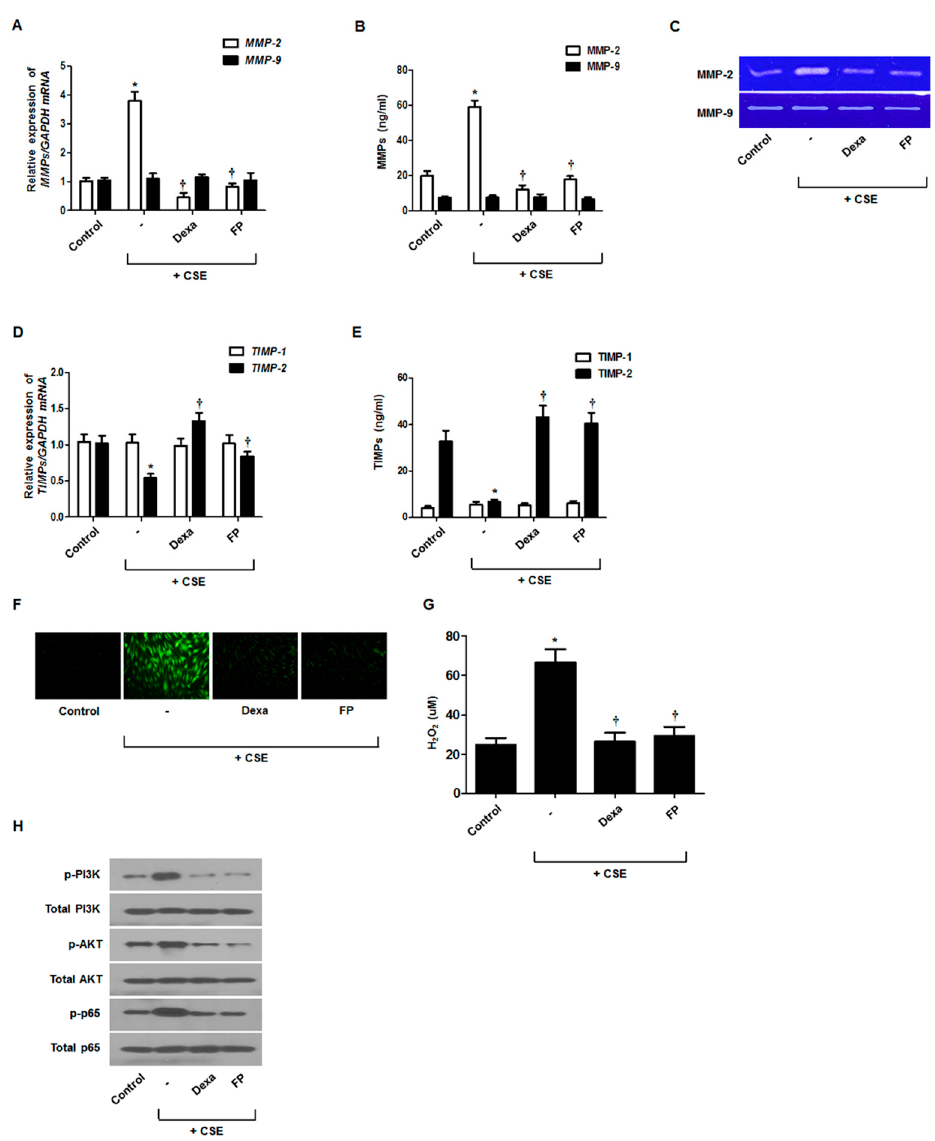
Figure 5. E ff ects of steroids on CSE-regulated MMP and TIMP levels in nasal fibroblasts. Nasal fibroblasts were pretreated with or without dexamethasone (Dexa, 2.5 µ M) and fluticasone propionate (FP, 2.5 µ M) before treatment with 5% CSE. The expression levels of MMP and TIMP mRNAs were determined by real-time PCR ( A , D ). MMP and TIMP protein secretion levels were determined using ELISA ( B , E ). The enzymatic activities of MMP-2 and MMP-9 were measured by gelatin zymography ( C ). Total ROS production and mitochondrial superoxides were quantified using the 2,7-dichlorofluorescein diacetate assay and Amplex Red assay ( F , G ). Levels of phosphorylated p-PI3K, p-Akt, and p-p65 were determined using western blotting ( H ). * p < 0.05 vs. control; † p < 0.05 vs. CSE only. Scale bar = 50 µ m